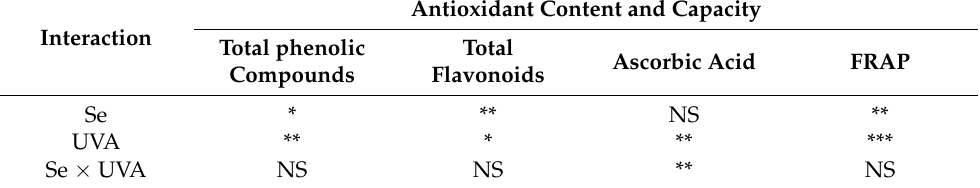
Figure 5. The composition of GSLs in broccoli microgreens. PRO, Progoitrin; GRA, glucoraphanin; SIN, sinigrin; 4-HGBS, 4-hydroxy-glucobrassicin; GBN, glucobrassicanapin; GER, glucoerucin; GBS, glucobrassicin; 4-MGBS, 4-methoxy-glucobrassicin; NGBS, neoglucobrassicin.